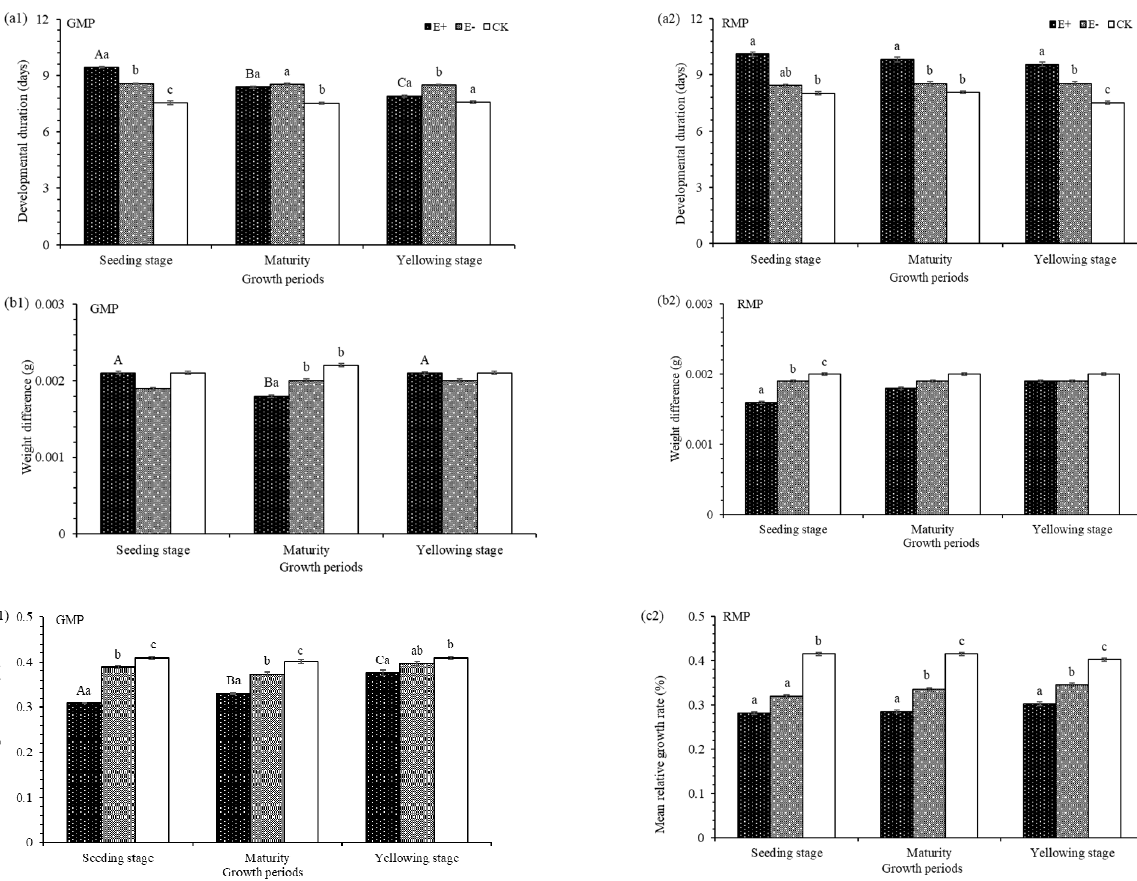
Figure 3. Developmental duration, weight difference and mean relative growth rate in green color morphs of pea aphids (GMP) and red color morphs of pea aphids (RMP) of Achnatherum inebrians with aqueous extracts of different growth periods ( a1 , a2 , b1 , b2 , c1 and c2 ). E+, endophyte-infected A. inebrians ; E − , endophyte-free A. inebrians ; CK, control. Different capital letters indicate that there are significant differences between different growth periods, and different small letters indicate that there are significant differences between different treatments ( p < 0.05).